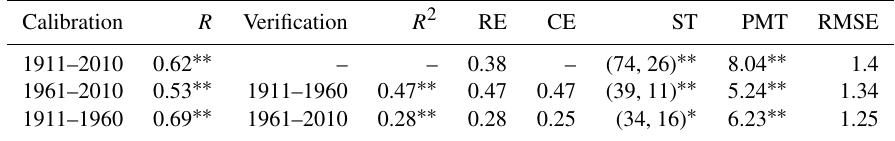
Table 3. Calibration and verification statistics of the PDSI reconstruction.